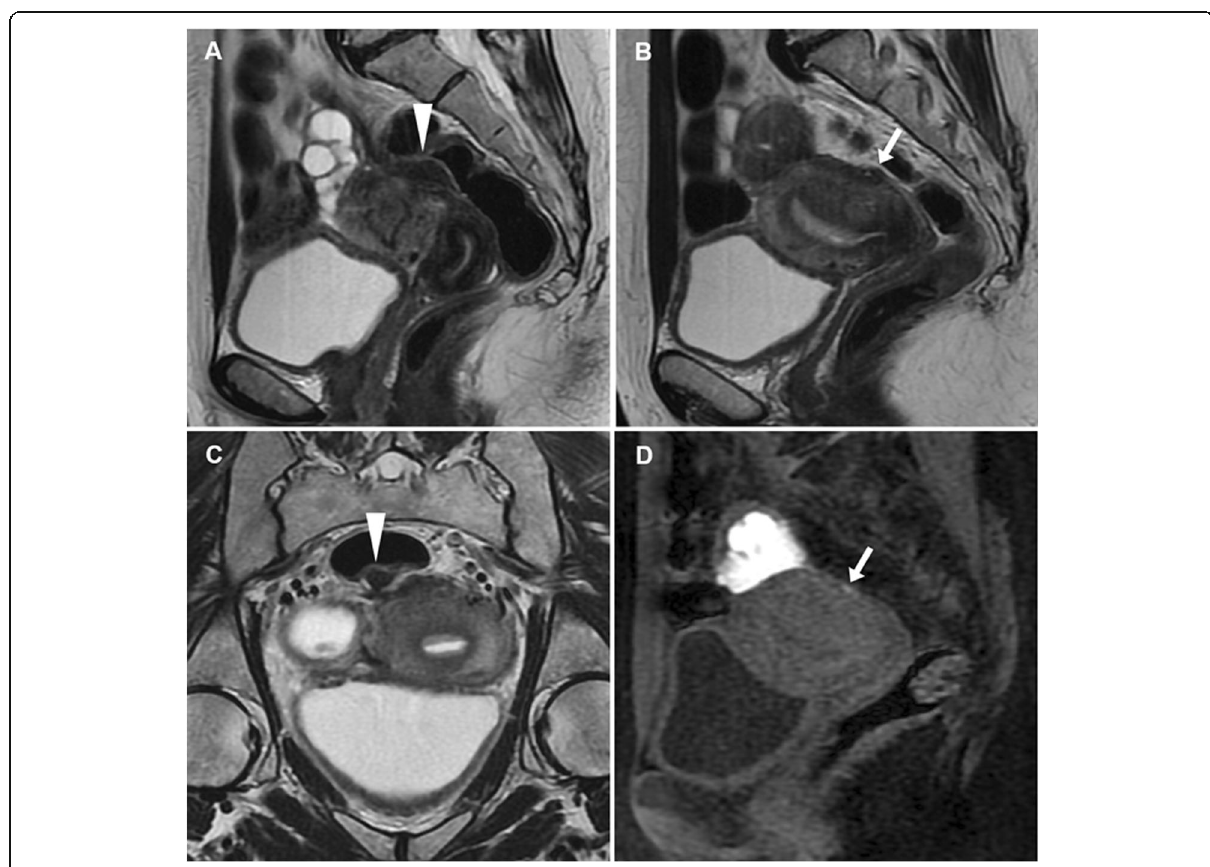
Fig. 17 In the same patient as Fig. 16, sagittal ( a ) and oblique-axial ( c ) T2-weighted images show a hypointense endometriotic plaque (arrowheads) that infiltrates the muscular layer of the anterior rectal wall. Sagittal T2-weighted ( b ) and sagittal fat-suppressed T1-weighted ( d ) images show additional endometriotic implants of the uterine serosa (arrows) demonstrating low T2-weighted, high T1-weighted signal